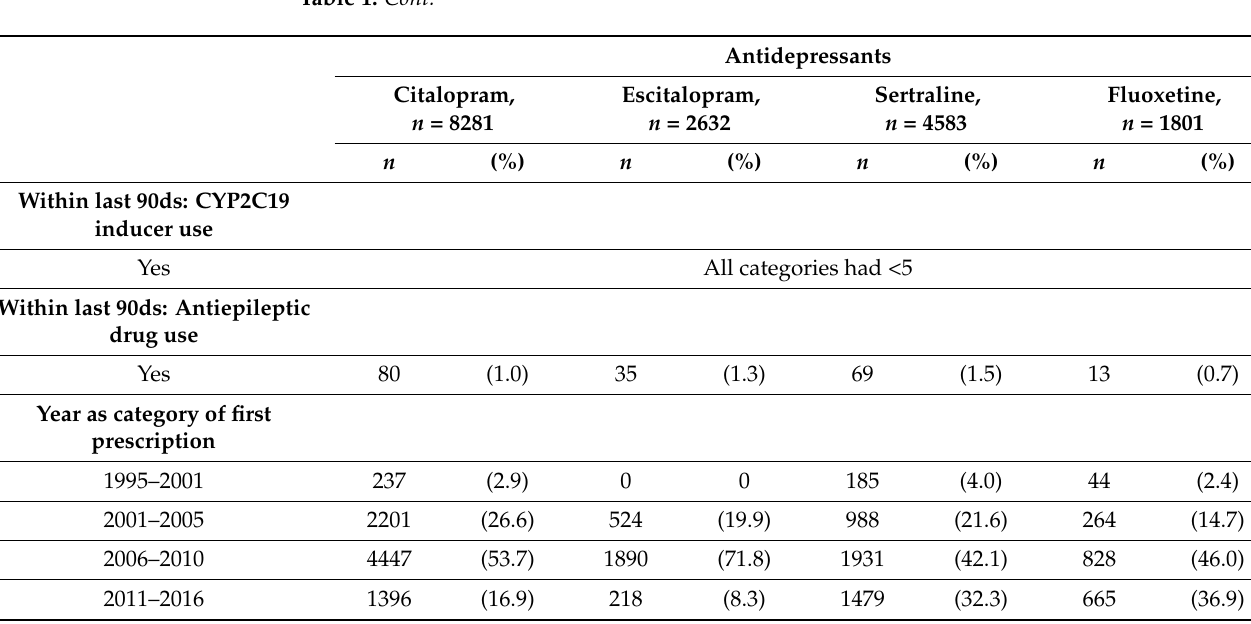
Table 2. Prevalence of CYP2C19 and CYP2D6 phenotypes of individuals born between 1981 and 2005, with a depression diagnosis any time between 1996 and 2012, with at least one prescription for escitalopram, citalopram, sertraline, or fluoxetine.